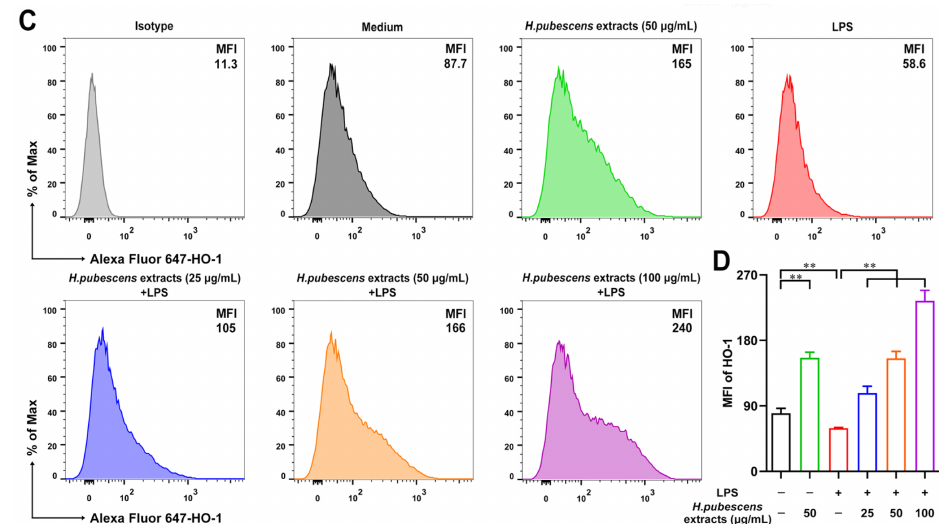
Figure 5. H. pubescens extracts upregulated both Nrf2 and HO–1 in LPS-irritated DCs. DCs were collected and washed with PBS after being cultured with the designed concentrations of H. pubescens extracts or plus LPS (100 ng/mL) for 24 h. Nrf2 ( A , B ) and HO–1 ( C , D ) expression of DCs were tested by FCM. All of the data are shown as means ± SD from three experiments. Analysis of variance (ANOVA) was employed. ** p <